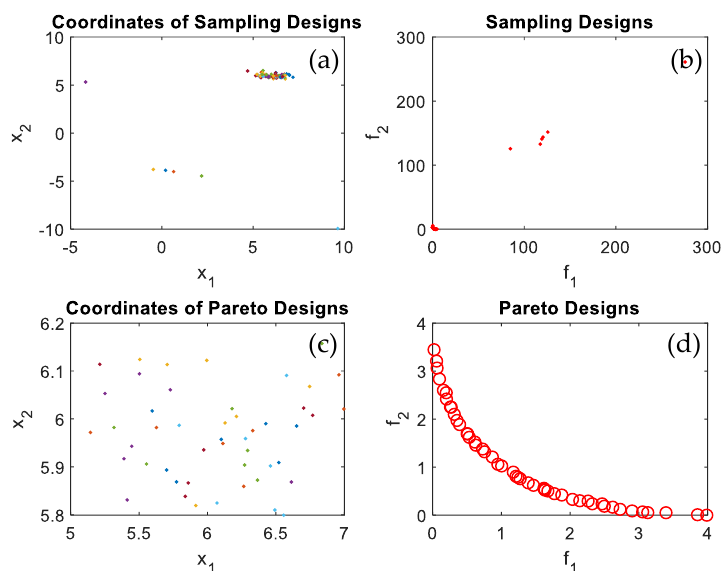
Figure 4. Computational simulations Pareto frontier determination of test function F1 ( a ) coordinates od sampling points; ( b ) sampling points in feasible design space; ( c ) coordinates of Pareto points; ( d ) the seeking Pareto frontier.